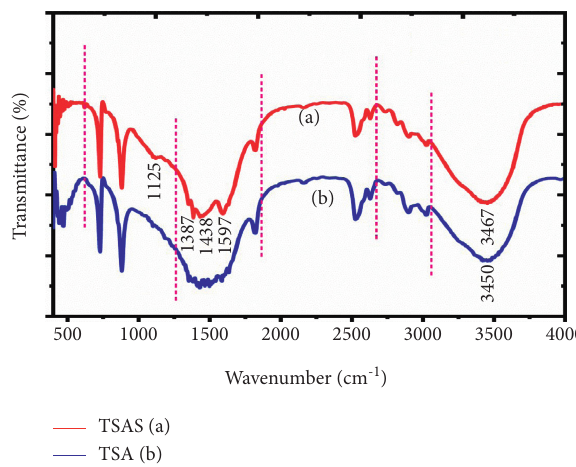
Figure 1: FTIR spectra of (a) biosilica nanoparticle from teff straw and (b) teff straw ash.